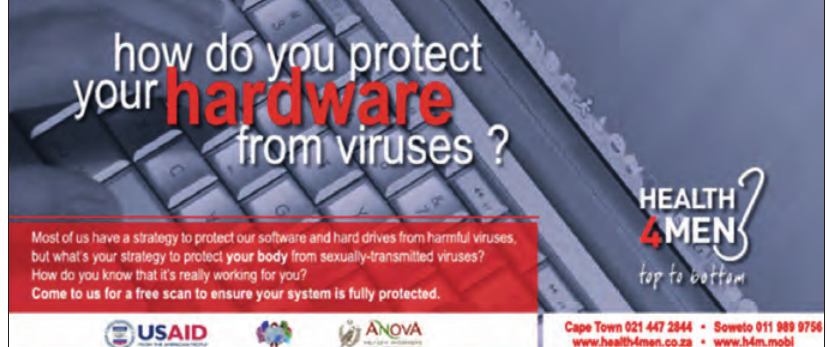
Fig. 2. An example of HIV risk-reduction messaging designed to reach gay-identified MSM through gay- targeted publications (the pink